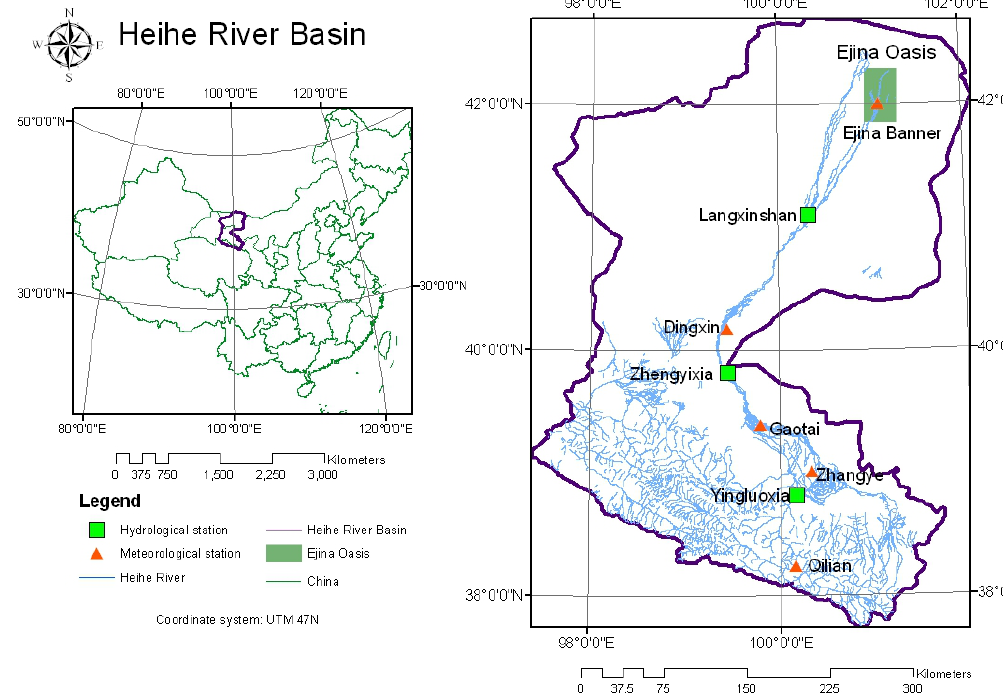
Fig. 1. The study area, meteorological stations and hydrological stations in Heihe River basin.